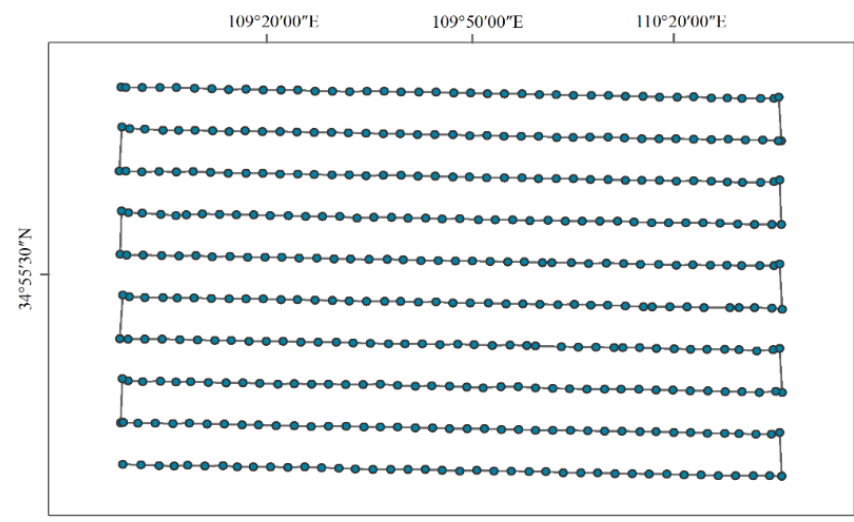
Figure 2. Flight route map in the research area.